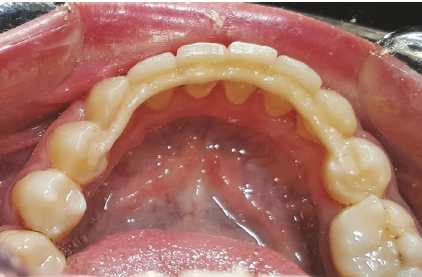
Figure 5: Bonded fixed retainer in situ, 2-year